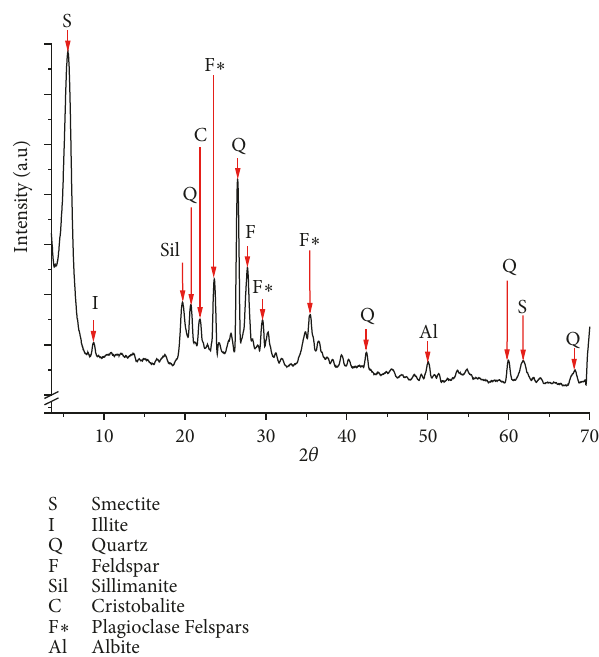
Figure2:PowderX-raydiffractogramoftheArmero-Guayabalclay.